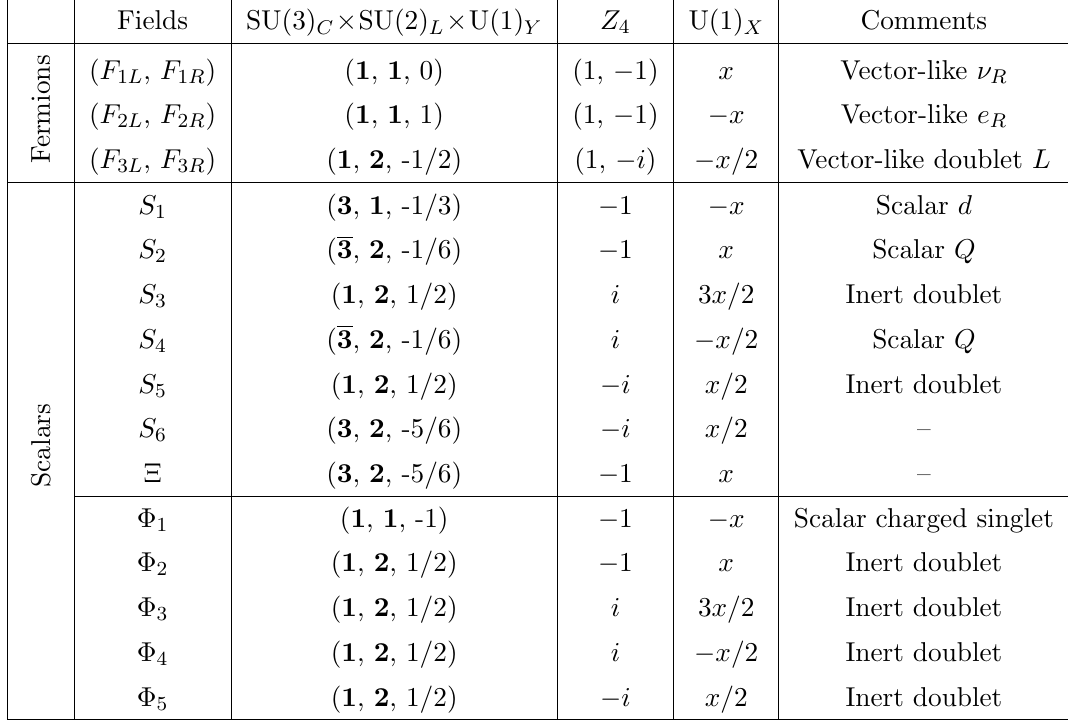
Charge assignments for the fermions and scalars that participate in the diagrams (cid:12)gures 1{4 considering no vector-like colored fermions. As before, new colored scalars with U(1) X charges appear. Other notations are the same as in table